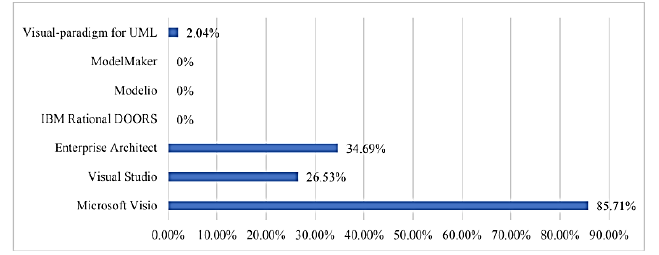
Fig. 8. Using tools for the system analysis.